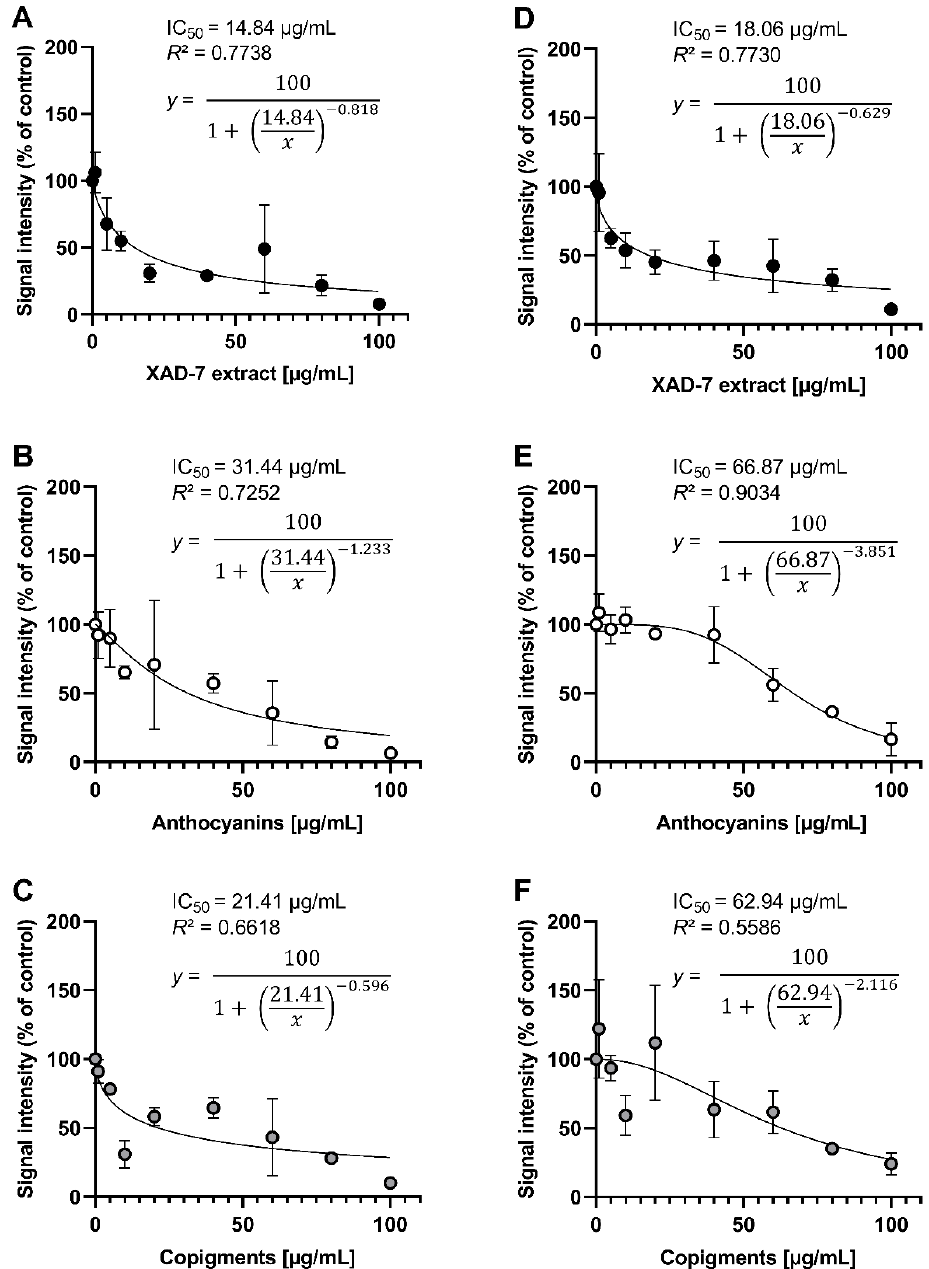
Figure 3. Galvinoxyl radical scavenging activity ( A – C ) and DPPH radical scavenging activity ( D – F ) of lingonberry XAD-7 extract and its anthocyanin (AF) and copigment fraction (CF). Shown is the mean ± standard deviation, the nonlinear equation curve, as well as the calculated R 2 and IC 50 values of three independent experiments.